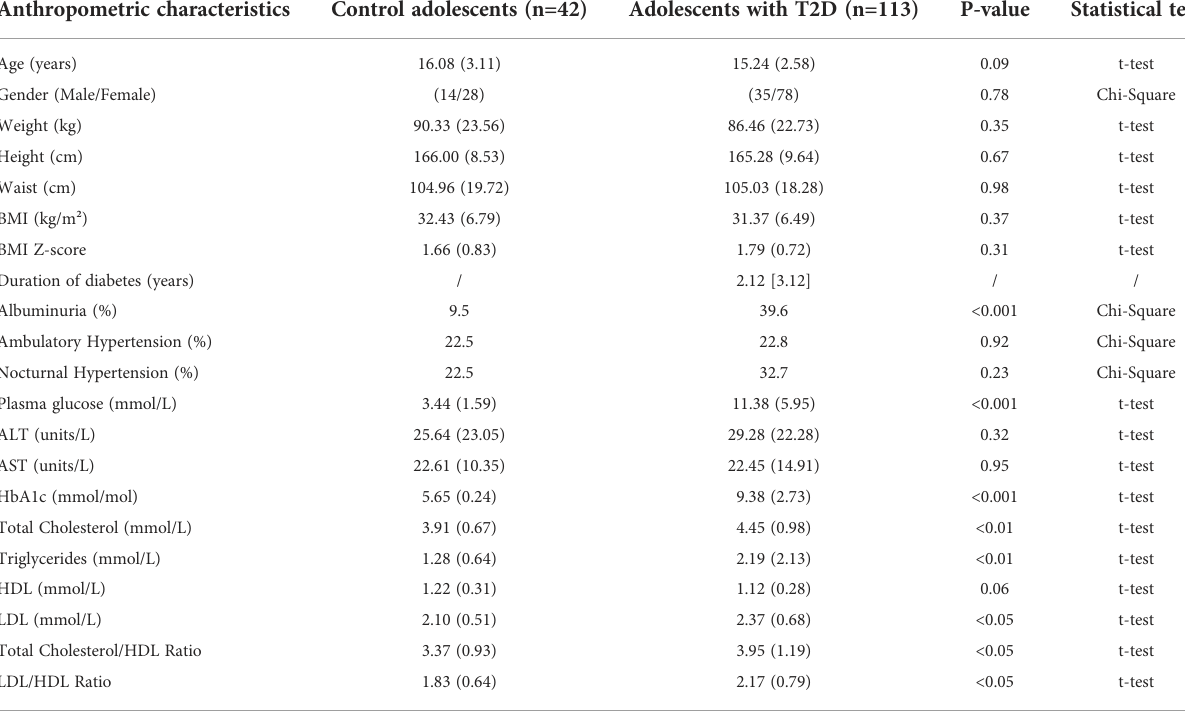
TABLE 1 Anthropometric characteristics of the primary cohort used in the study. Anthropometric